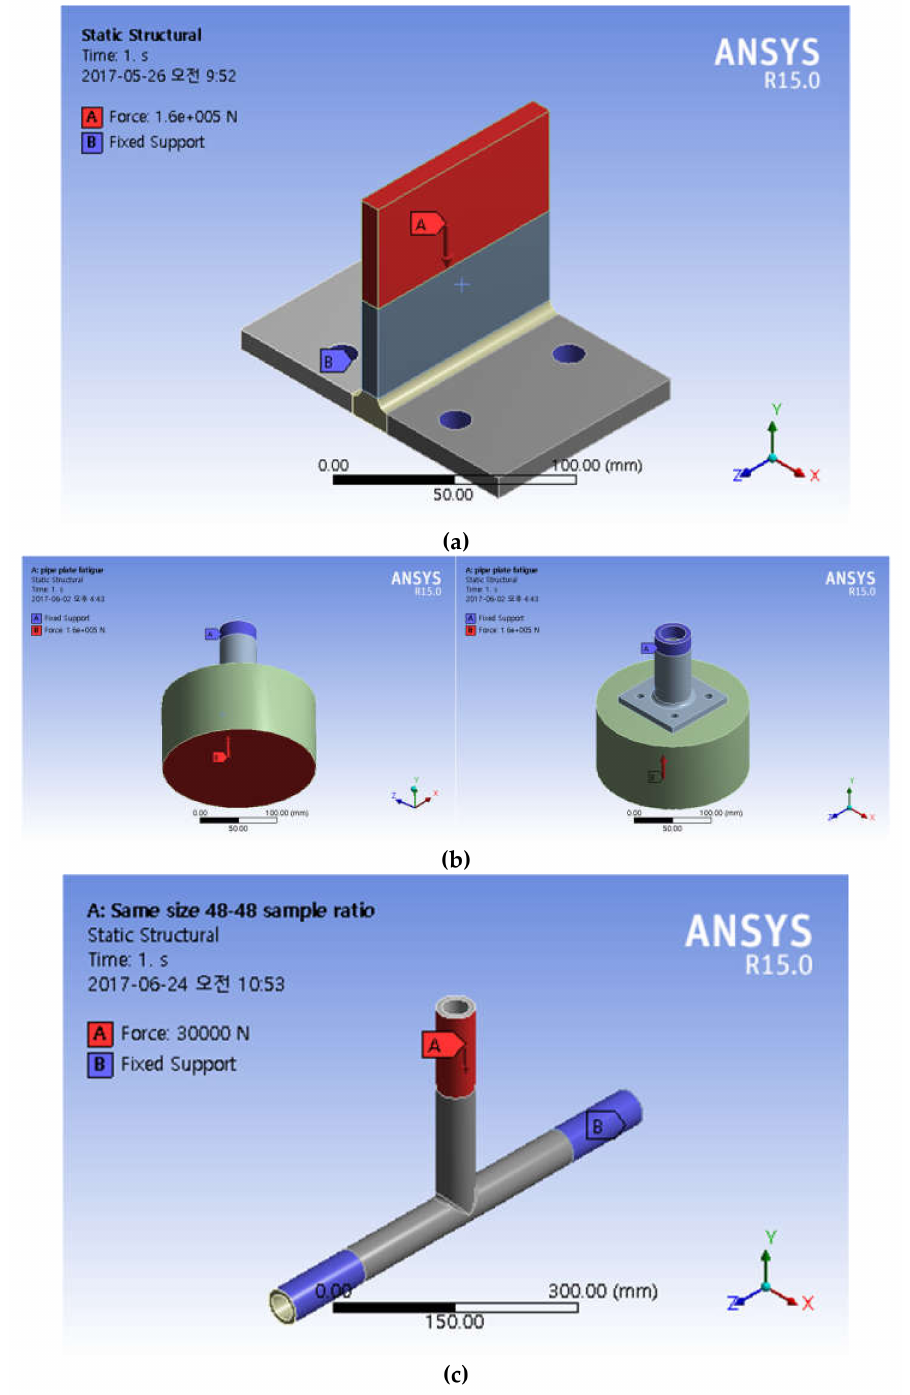
Figure 3. Supports and the points and directions of the testing force ( a ) for static structures ( b ) for pipe plate fatigue ( c ) for same size sample